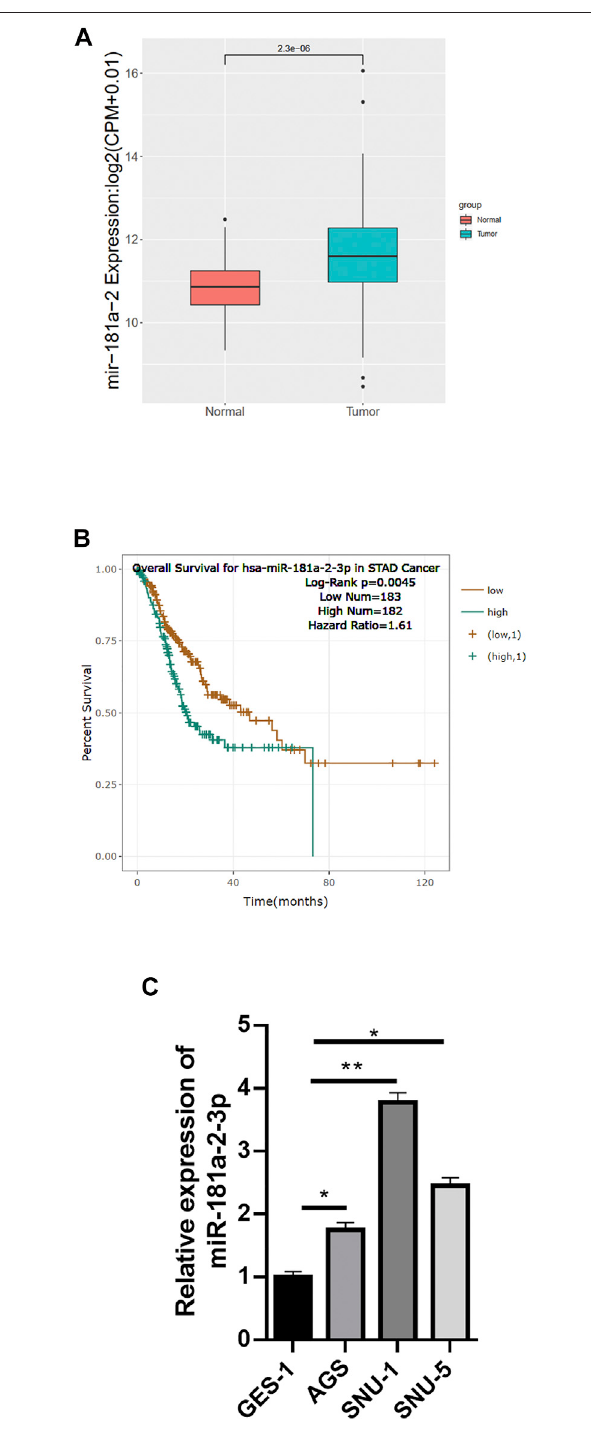
FIGURE 1 | miR-181a-2-3p is up-regulated in GC cells. (A) The differential expression of miR-181a-2 in TCGA-STAD dataset (red: normal, blue: tumor); (B) Overall survival curves of patients with high/low miR-181a-2- 3p expression (grouping according to median expression of miR-181a- 2-3pinTCGA); (C) qRT-PCRmeasuredmiR-181a-2-3pexpressioninGES-1, AGS, SNU-1, SNU-5 cells; * p < 0.05, ** p <